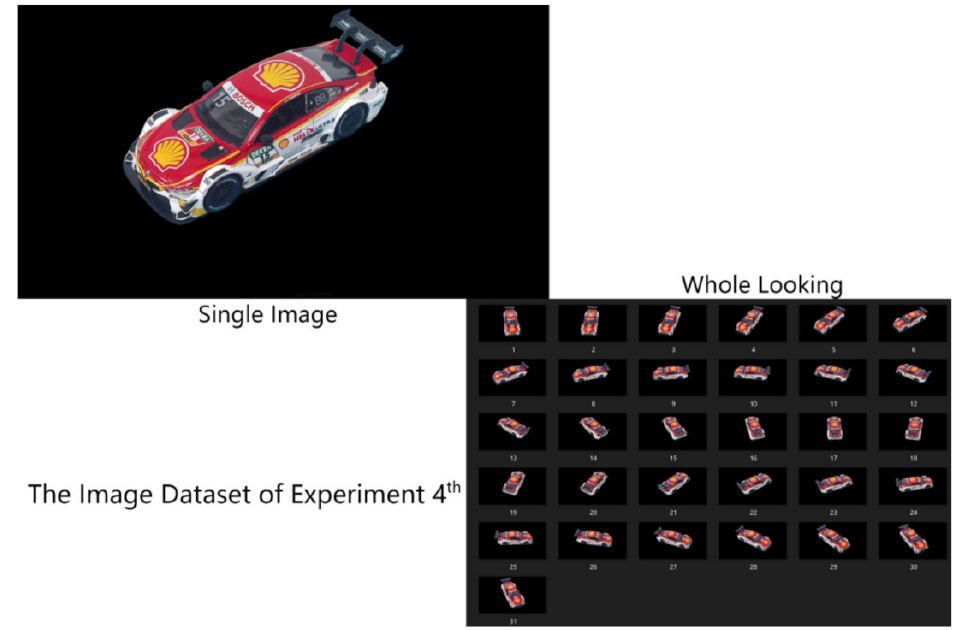
Figure 18. The image dataset used in experiment